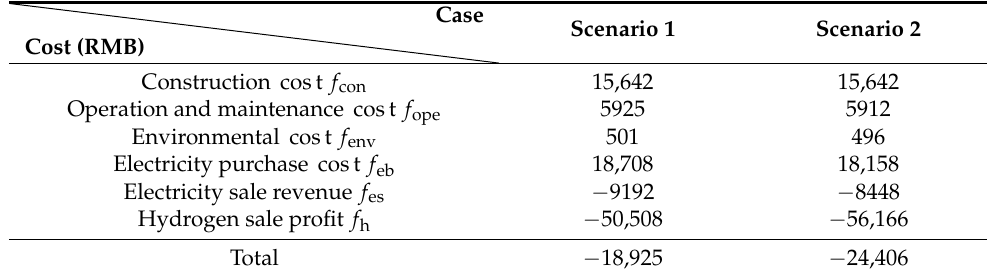
Table 4. Cost details of different